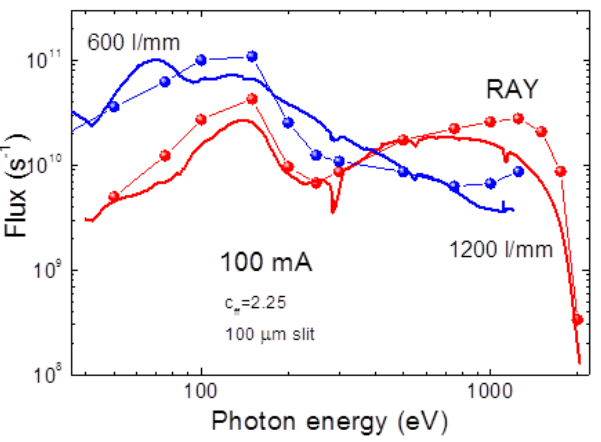
Figure 2: Photon flux at the sample position in the reflectometer, normalized to 100 mA ring current (blue (600 l/mm) and red curve (1200 l/mm)), in comparison with raytrace calculation with RAY (points). Typically BESSY-II runs with 300 mA.